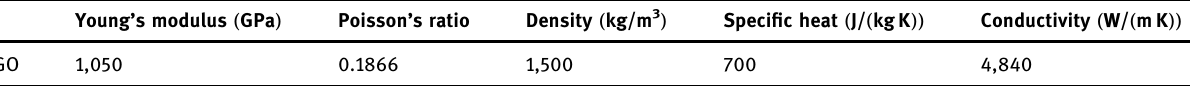
Table 5: Thermophysical parameters of GO